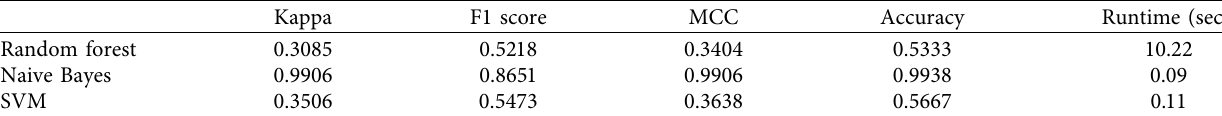
Table 11: Comparing performance results of the three